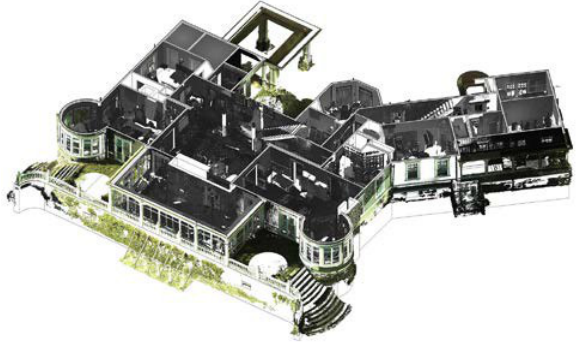
Fig.8 – BIM created from survey and laser